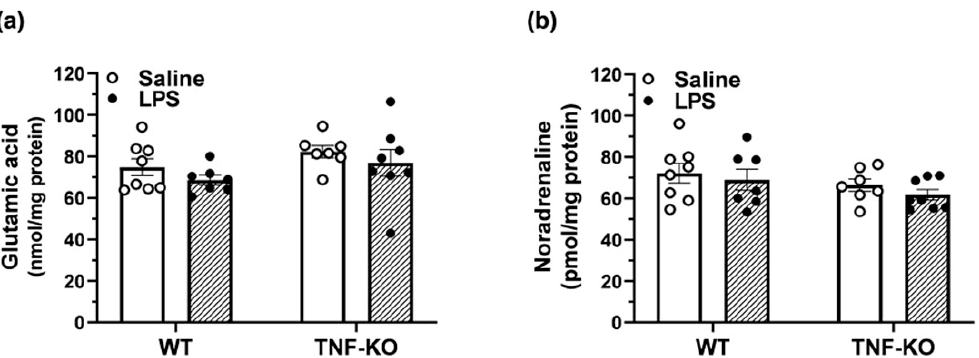
Figure 6. No change in neurotransmitter content in the hippocampus of male mice. The hippocampi of male WT and TNF-KO mice were isolated immediately after the end of the BMT. The levels of glutamate ( a ) and noradrenaline ( b ) were quantified by UHPLC-MS/MS. There were no differences in the level of neurotransmitters between groups. Results are the mean ± SEM of n = 7–8 animals per group.